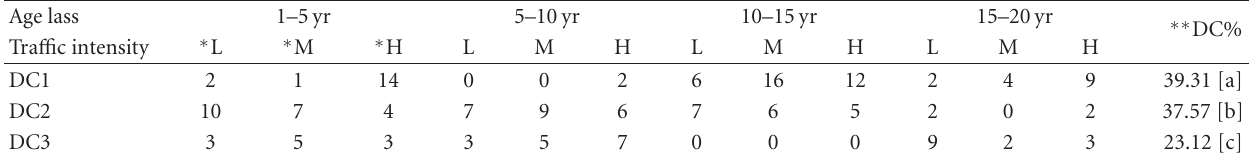
Table 8: Distribution of damaged trees based on distance from centerline of the skid